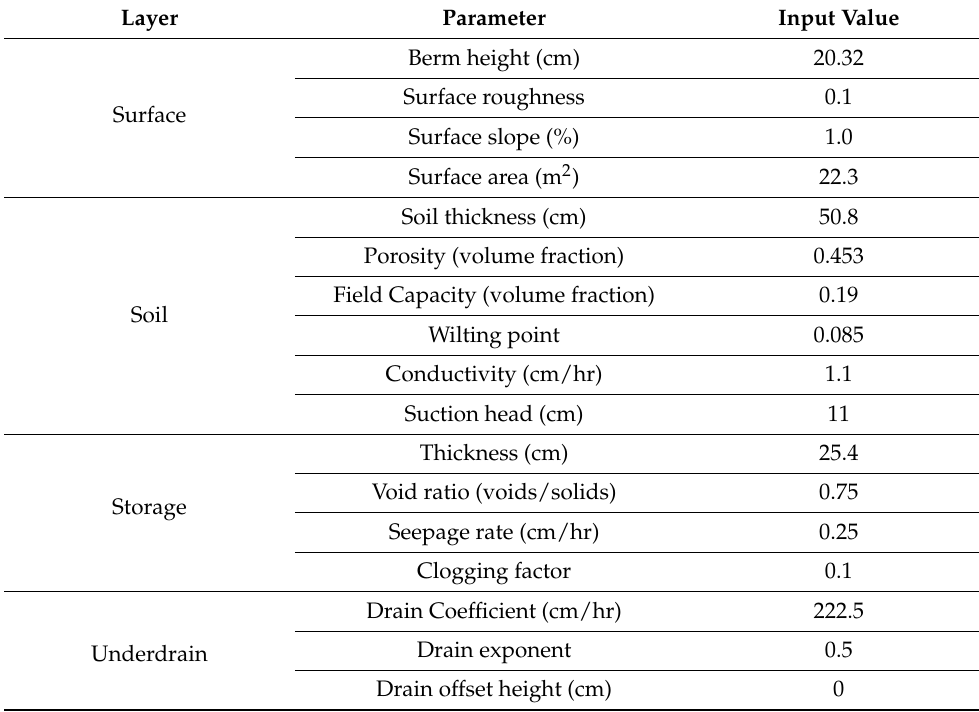
Table 2. PCSWMM input parameters for a bioretention cell representing a streetside stormwater